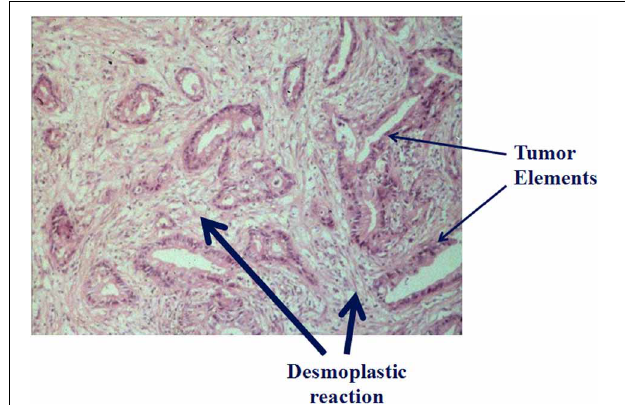
FIGURE 1 | Histology of pancreatic cancer: Hematoxylin and eosin stained section of a human pancreatic cancer section showing tumor elements (thin arrows) embedded in an abundant collagenous stroma (thick arrows) ( previously unpublished figure